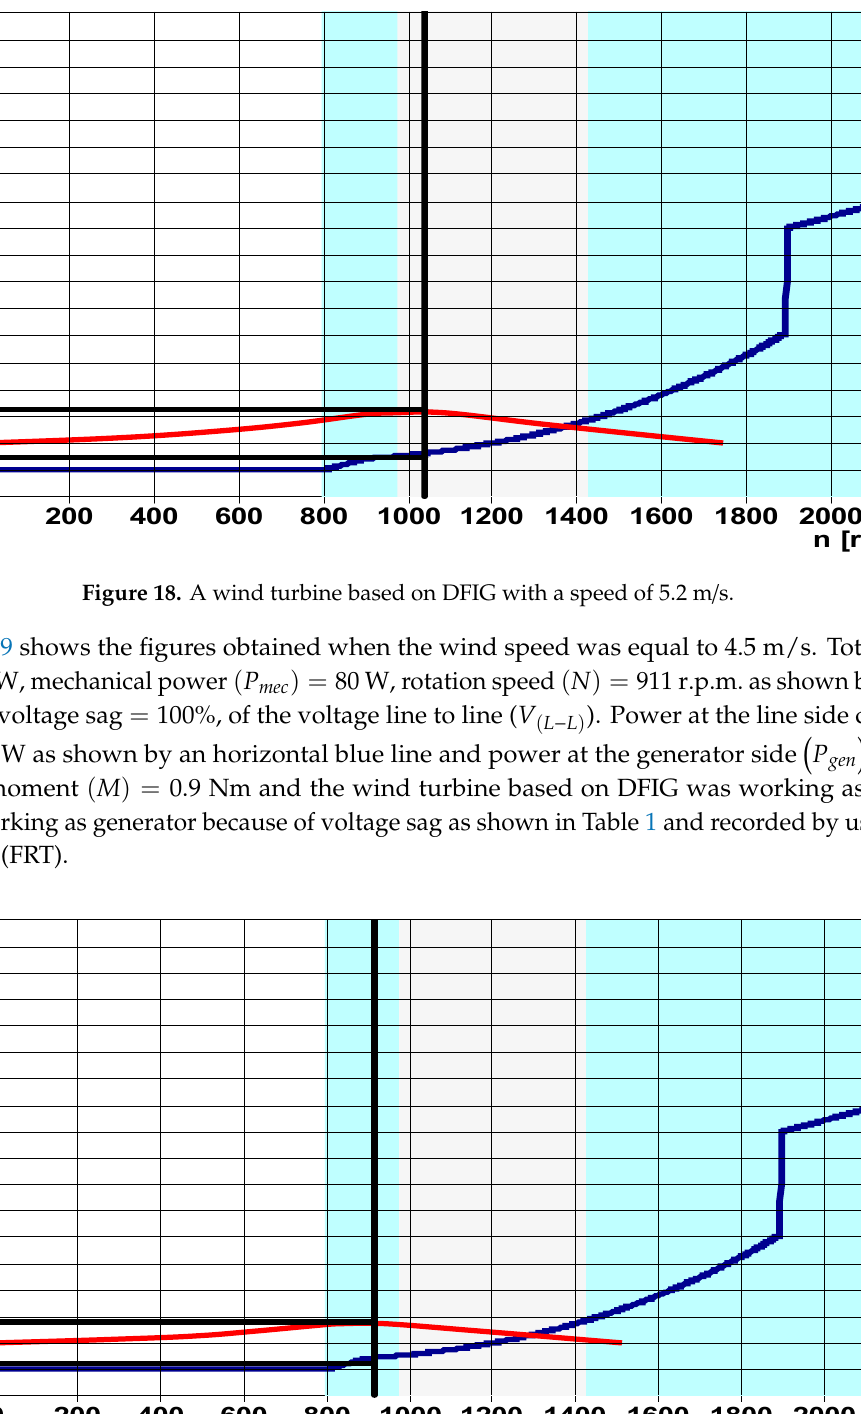
Figure 17. A wind turbine based on DFIG with a speed of 6.5 m/s.